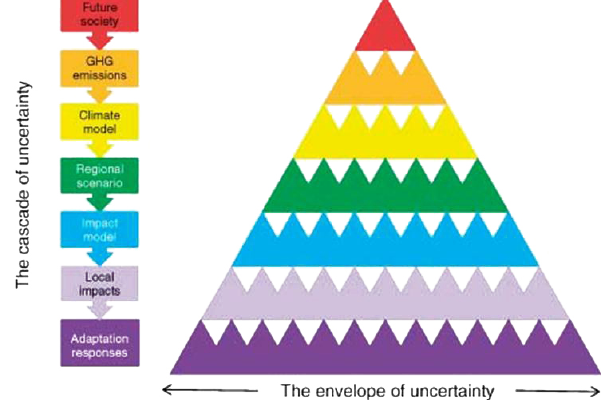
Figure 1. Cascade of uncertainty; the increasing numbers of trian- gles at each level symbolise the growing number of permutations and hence expanding envelope of uncertainty. Source: Wilby and Dessai